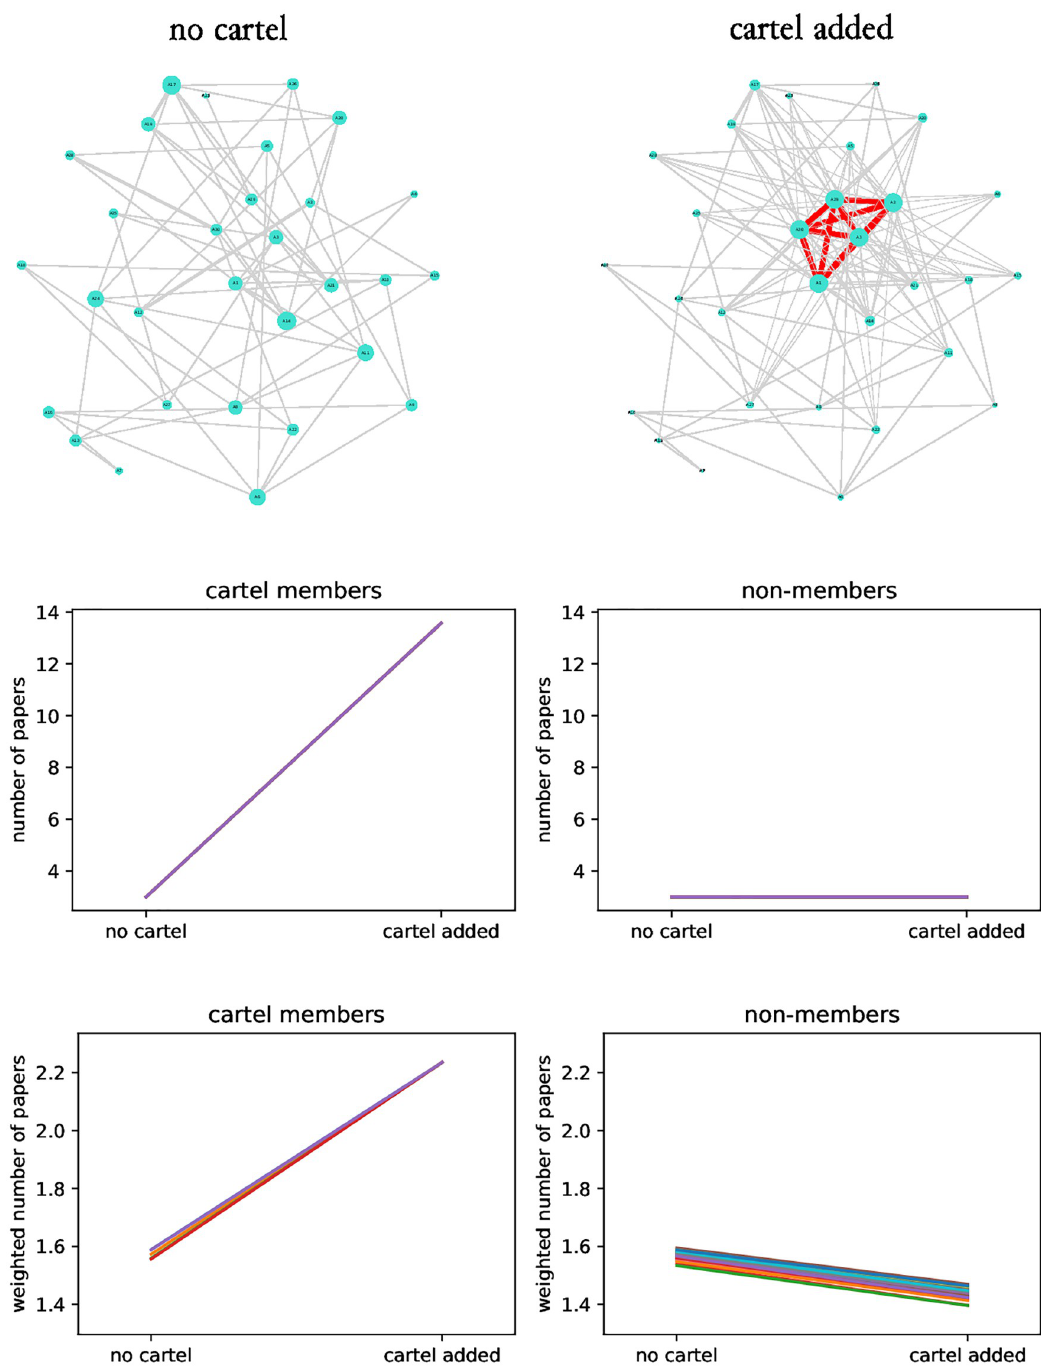
Fig 5. The effect of cartel formation on the productivity of cartel members and non-members: Equal prior productivity of authors. The top panels illustrate the collaboration graph without and with cartel formation. The middle panels show how the number of papers produced by members and non-members changes because of founding cartel. The bottom panels illustrate the same but using the weighted number of papers as a measure of productivity. Collaboration graphs were formed with c = 30, k = 3, p = 60, p c = 1 and κ = {1, 2, 3, 29, 30} (cartel composition is arbitrary as all authors are the same in terms of prior productivity). Averages of 1000 repetitions are plotted and different colours represent different authors.